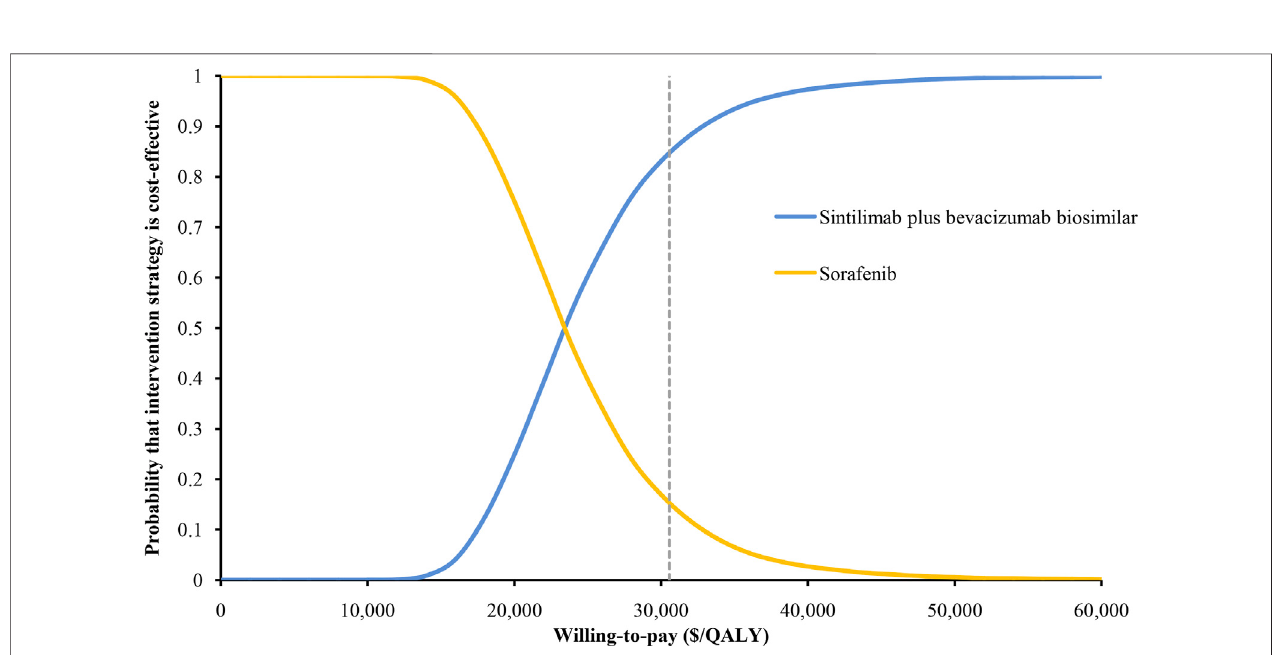
FIGURE 4 | Cost-effectiveness acceptability curves. QALYs, quality-adjusted life-years.